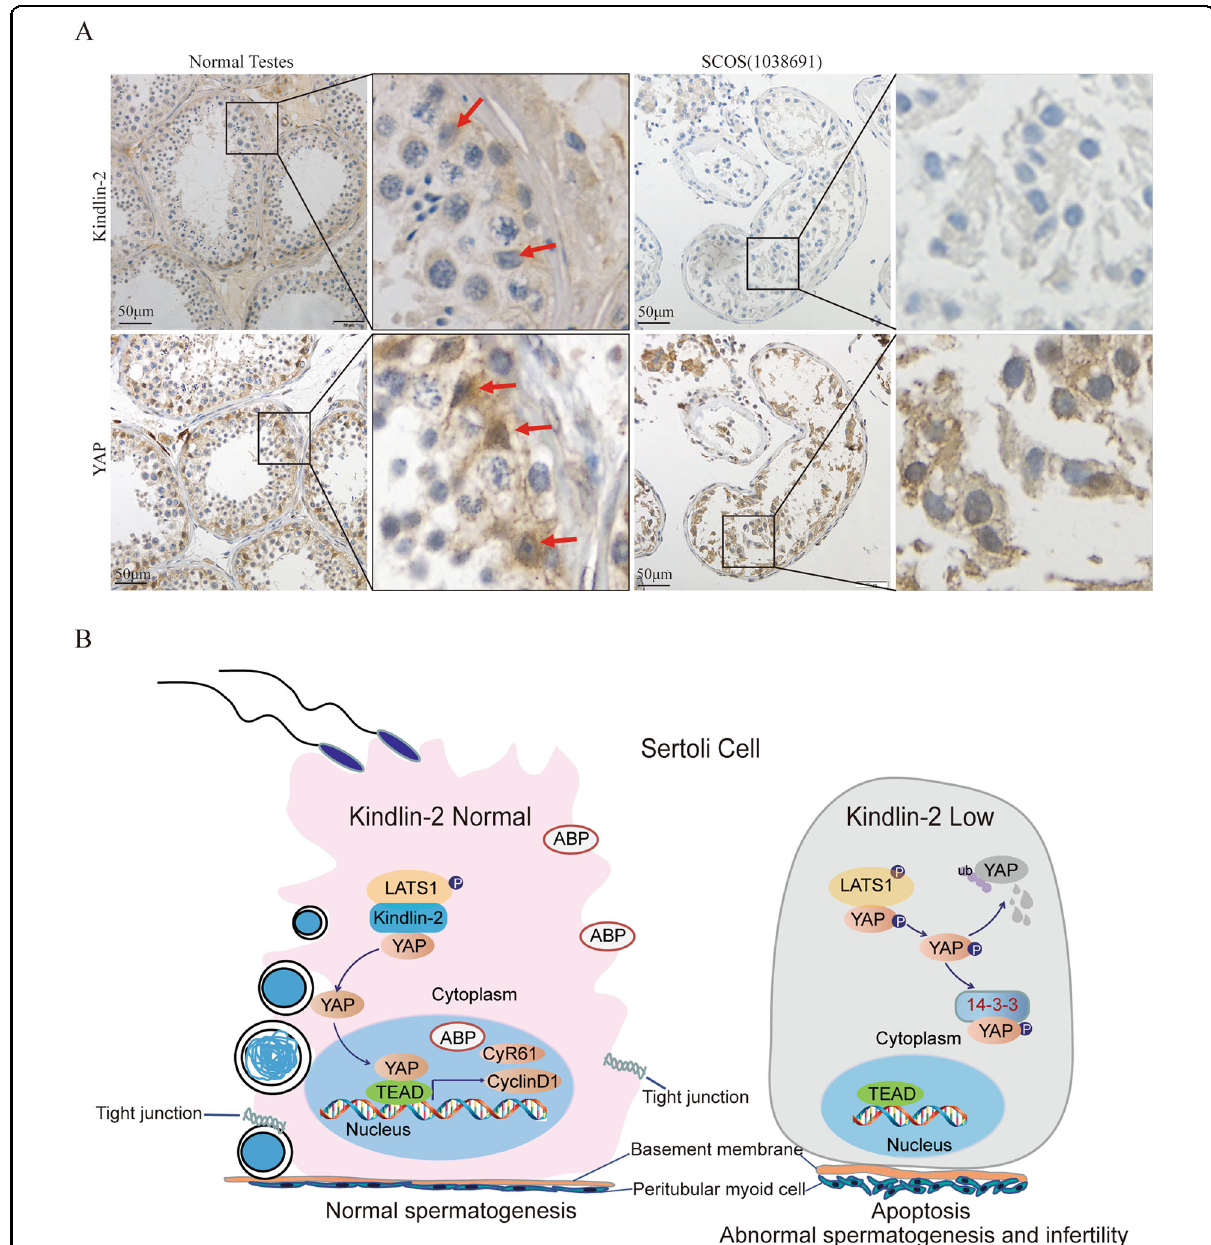
Fig. 6 Expression of Kindlin-2 and YAP in human SCOS and role of Kindlin-2 in Sertoli cell. A Representative IHC staining of Kindlin-2 and YAP expression in normal human testes and SCOS patient specimens. Scale bar, 50 μ m. Local-magni fi cation is on the right panel of each pictures respectively. B Working model for the role of Kindlin-2 in Hippo/YAP signaling regulation and Sertoli cell functions. Loss of Kindlin-2 in Sertoli cells mediating YAP activation in SCs growth, and leads to change of biological